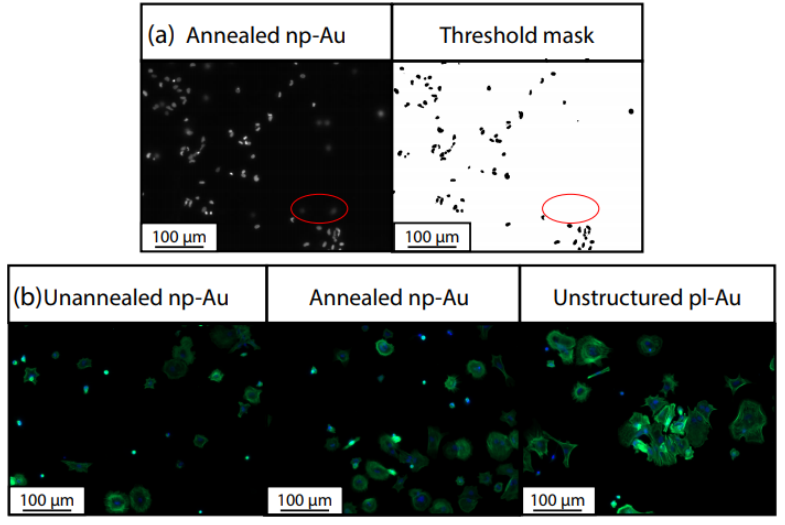
Figure A2. Representative images of pre- and post-experiment cell counting. ( a ) Pre-experiment image of cells seeded for 4 h, stained with NucBlue Live Reagent, with threshold mask shown to the right. The threshold method was chosen to minimize the number of (dim, low-contrast) floating cells in the count. An example of out-of-plane cells absent from the thresholded image are circled in red. ( b ) Fluorescence microscopy images of fixed cells, showing nuclei (DAPI) in blue and f-actin (phalloidin) in green. Thresholds were computed only for the DAPI channel.